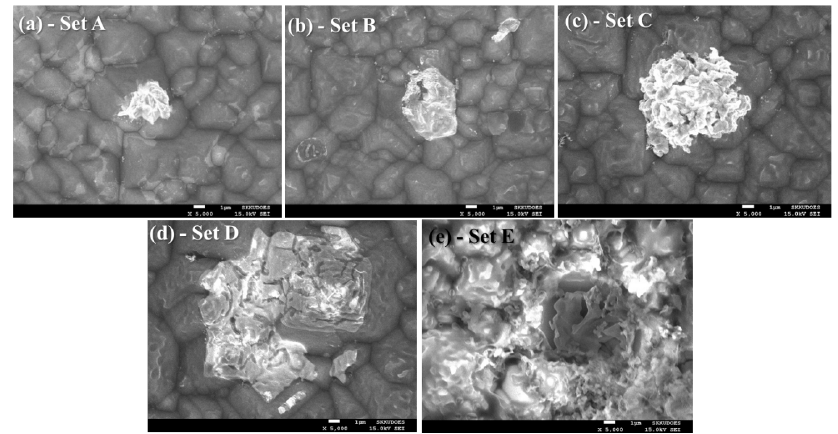
Figure 3. Scanning electron microscopy (SEM) images for the transition state of formed electrode between Si and the front-side electrode when the co-firing peak temperature profile set varied from ( a ) Set A to ( e ) Set E.